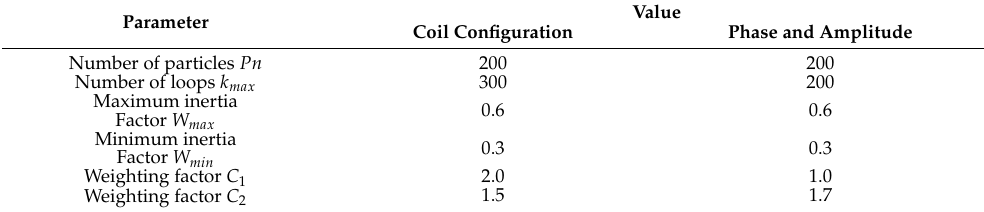
Table 3 lists the parameters of PSO used in the optimization. Table 3. Parameters of